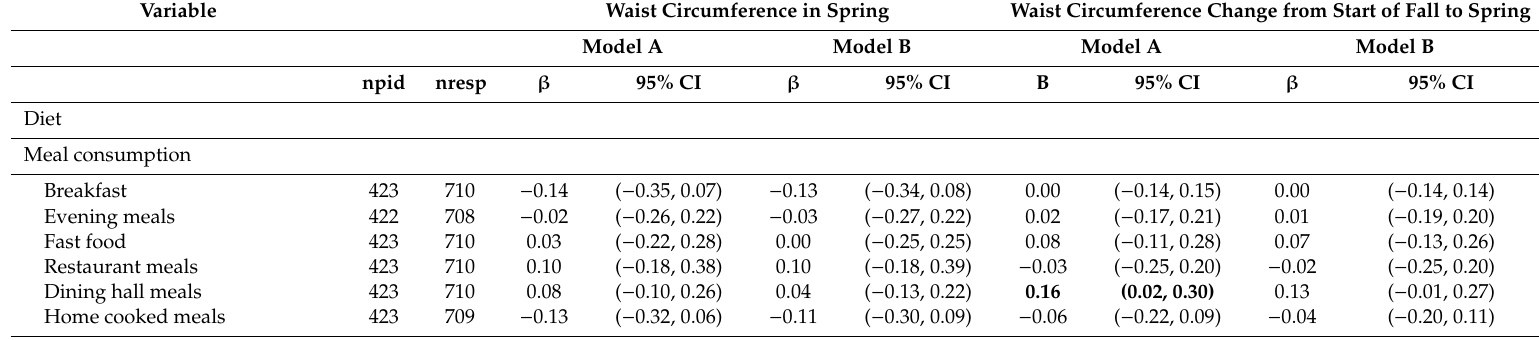
Table 5. Results of the longitudinal linear mixed e ff ect models examining if students’ survey responses on weight-related behavioral factors were associated with their waist circumference, or waist circumference